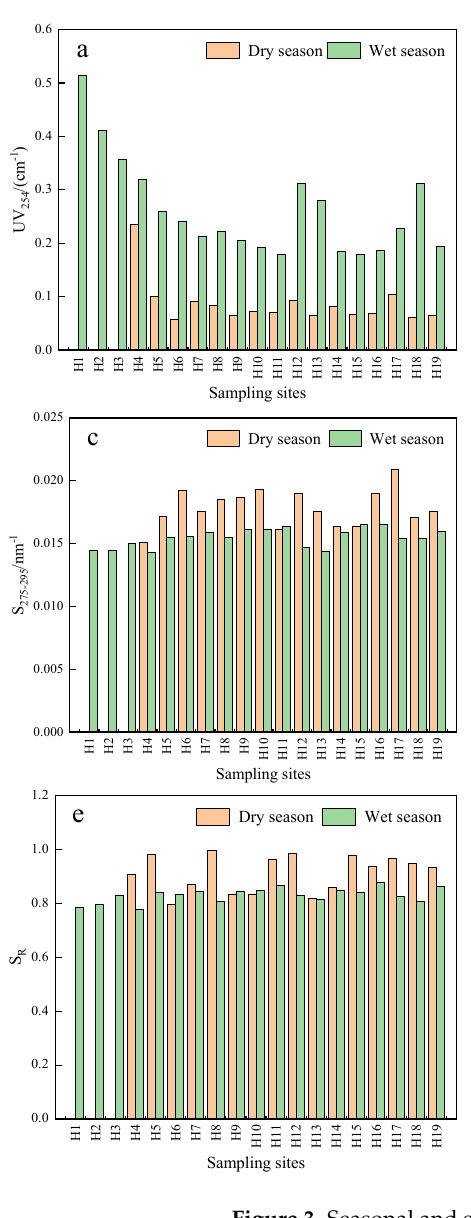
Figure 3. Seasonal and spatial variations of UV-visible spectral parameters. ( a ) UV 254 ; ( b ) SUVA 254 ; ( c ) S 275–295 ; ( d ) S 350–400 ; ( e ) S R . ( c ) S 275–295 ; ( d ) S 350–400 ; ( e ) S R